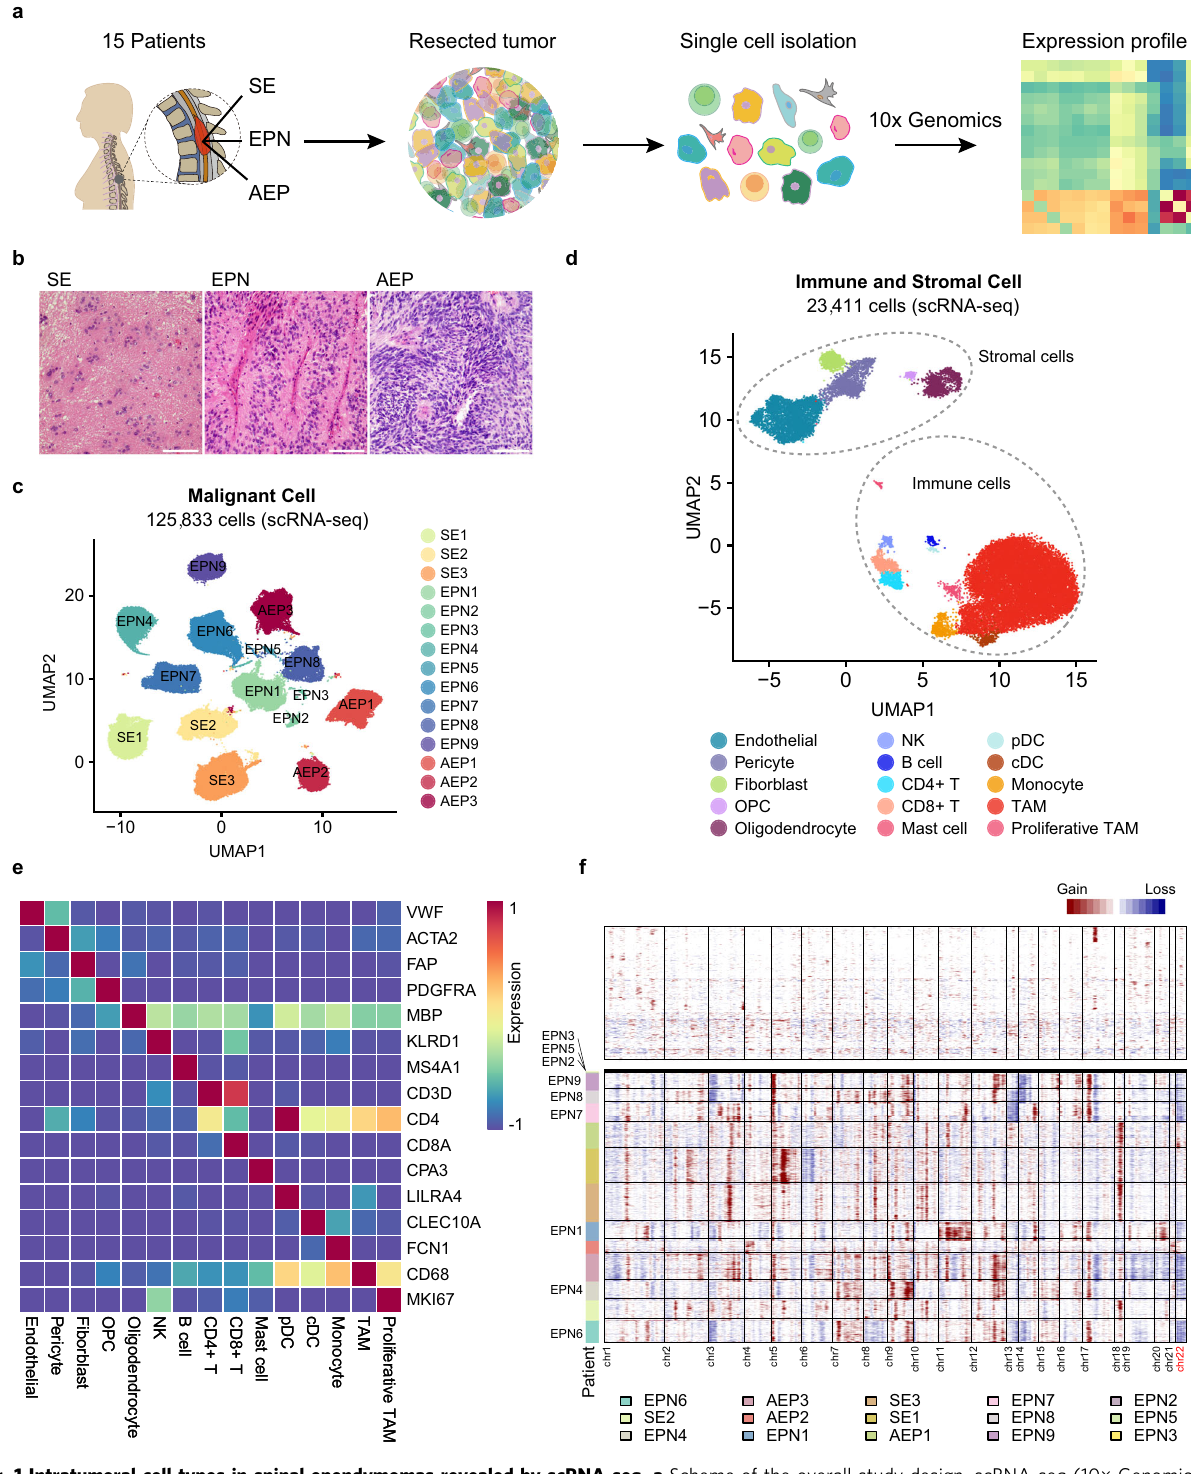
Fig. 1 Intratumoral cell types in spinal ependymomas revealed by scRNA-seq. a Scheme of the overall study design. scRNA-seq (10× Genomics) was applied to cells isolated from three subtypes of spinal ependymomas. b Hematoxylin and eosin (HE) staining of tumors from different cancer subtypes. The scale bar represents 30 μ m. Images shown are representatives of more than three samples from three independent experiments. c Uniform Manifold Approximation and Projection (UMAP) plot showing the patient distribution of malignant cells, without donor effect correction. d UMAP plot of stromal and immune cell types from all patients (SE1-3, AEP1-3, EPN1-9), donor effect corrected by BBKNN. e Heatmap showing the expression of canonical gene markers of stromal and immune cell types. f Inference of copy-number variations (CNVs) from scRNA-seq. Each row corresponds to a cell. The top panel represents nonmalignant cells, and the bottom panel represents malignant cells, ordered by the patient. See also Supplementary Figs. 1 and 2 and Supplementary Data 1 and